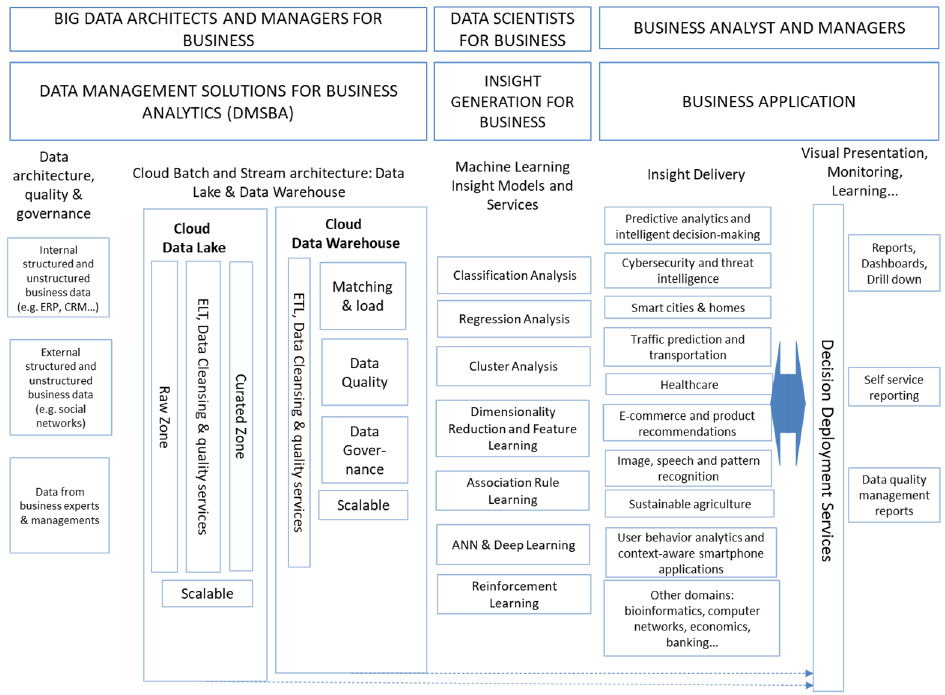
Figure 1. Data-driven architecture for nonmilitary